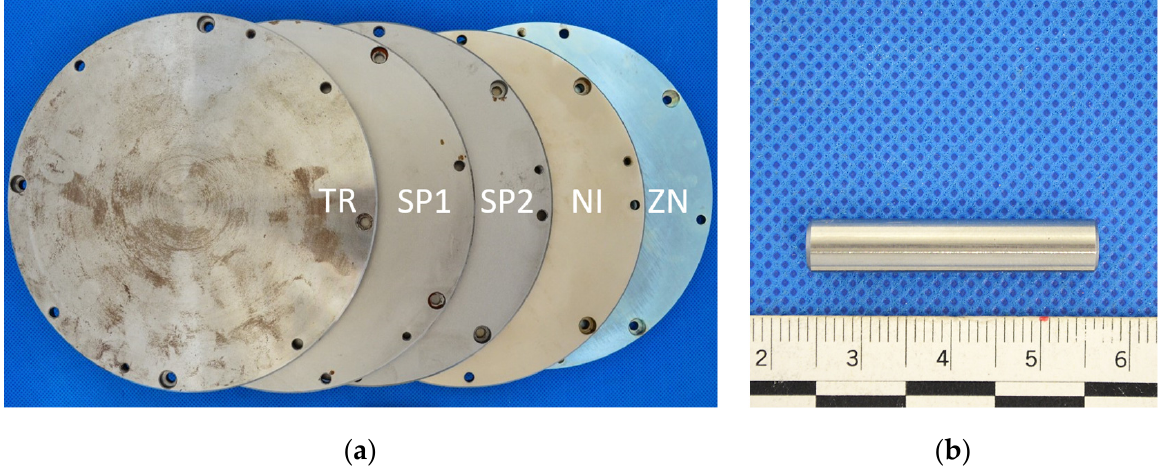
Figure 1. Specimens used in the study: ( a ) disks and ( b ) representative pin.